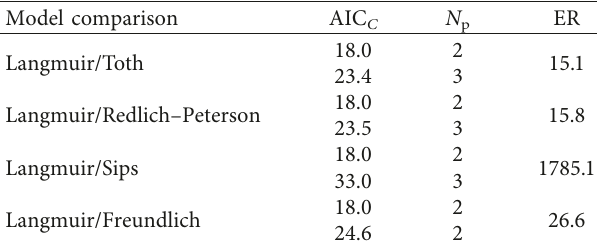
Table 9: Comparison of the Langmuir model with others using evidence ratio (ER).